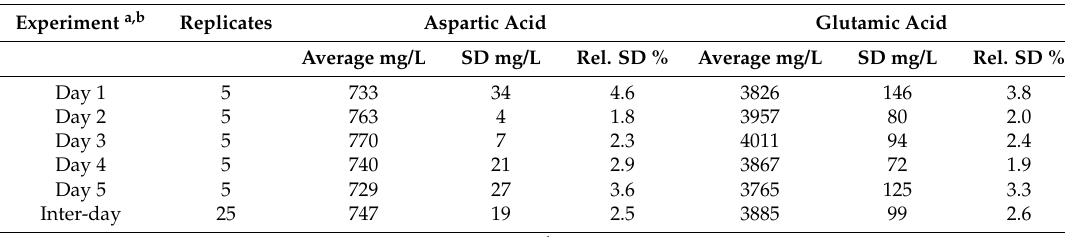
Table 1. Intra- and inter-day repeatability; sample of red, fully ripe tomato.